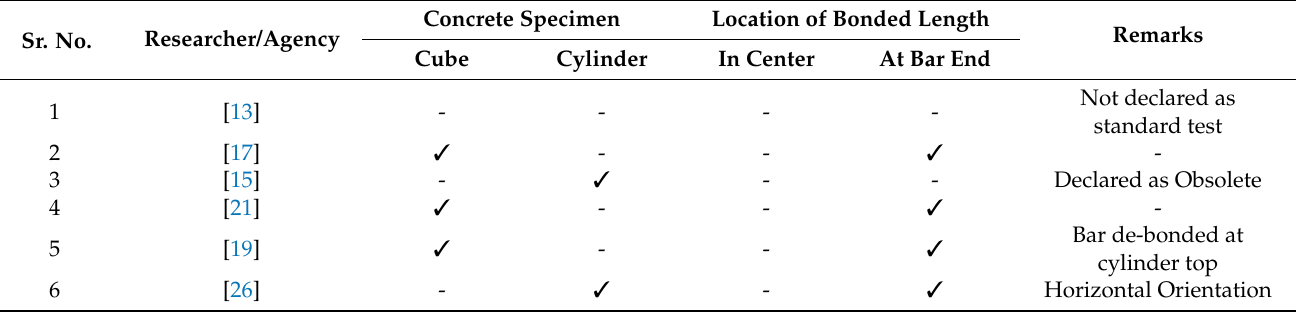
Table 2. Summary of different approaches of pullout tests to evaluate bond strength [M. Yousaf].